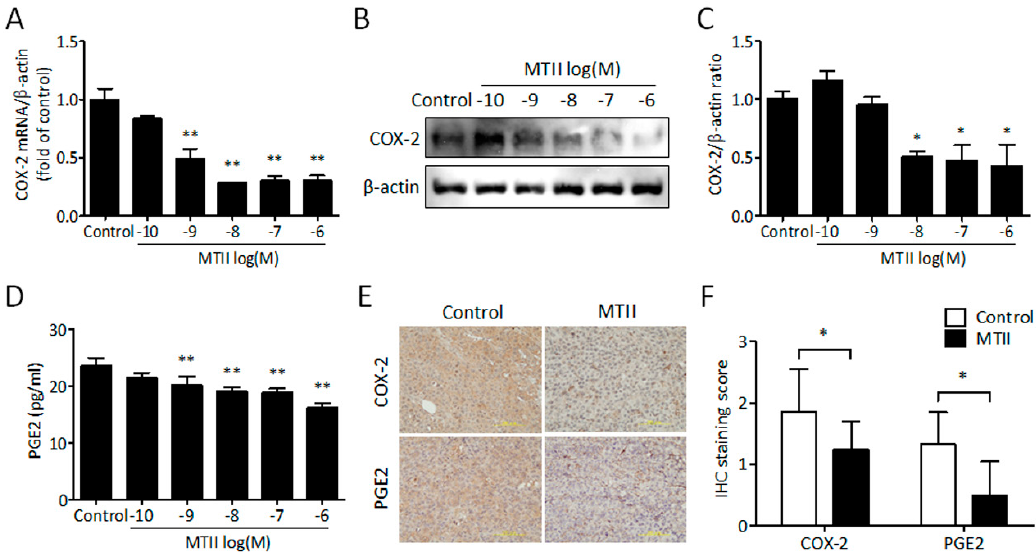
Figure 4. Effect of MTII peptide on COX-2 expression and PGE2 production in melanoma. ( A ) Relative COX-2 mRNA expressions were analyzed by real-time PCR. Data were expressed as means ± SD of the fold change compared with the control from duplicate experiments. ( B ) Western blot analysis of COX-2 expression in MTII-treated B16-F10 melanoma cells. ( C ) The bar chart shows the protein ratio from duplicate experiments. The data are expressed as fold changes ± SD. ( D ) The levels of secreted PGE2 protein (pg / mL) were determined by ELISA assay kit from triplicate experiments. ( E ) Representative profiles of COX-2 and PGE2 expression in control and MTII-treated melanoma tissues. Scale bar, 200 µ m. ( F ) The bar char was calculated and expressed as the mean ± SD from six experiments. *: p < 0.05, **: p < 0.01.